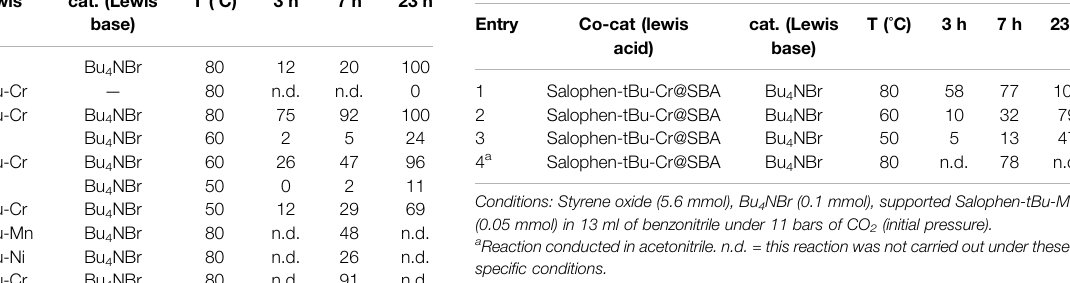
TABLE 1 | Yield (%) of styrene carbonate obtained with Cr-salophen